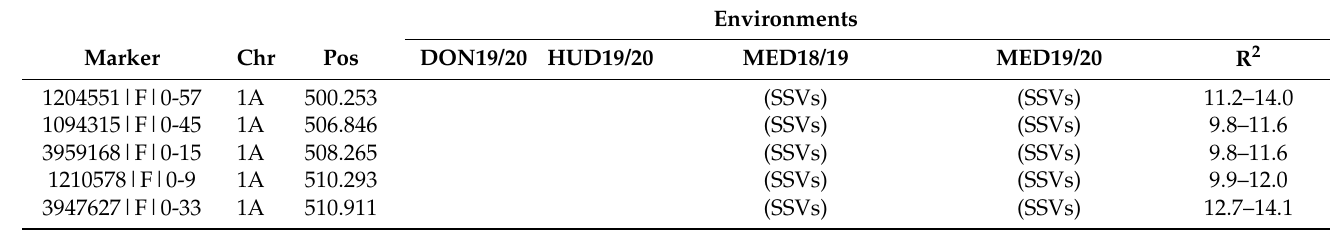
Table 2. Stable and pleiotropic MTAs of dough strength (SSVs), relative performance of dough strength (RP.SSVs), grain yield (GY), and relative performance of grain yield (RP.GY) in multiple synthetic derivative lines grown under optimum (DON19/20) and heat (HUD19/20, MED18/19, and MED19/20)